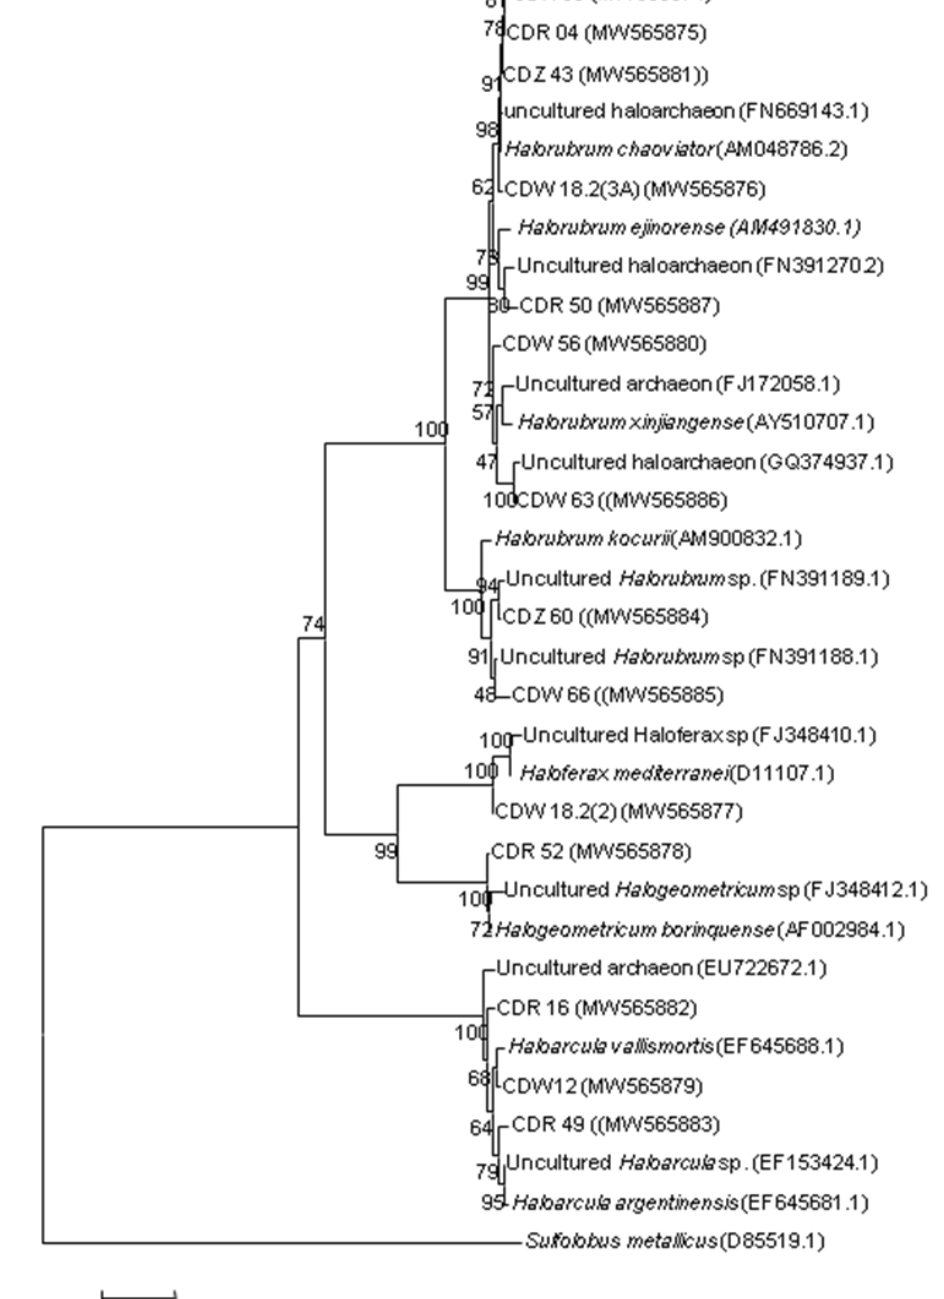
Figure 2. Phylogenetic relationships among haloarchaeal group members, isolated from halite-crystal salts (CDR, CDW, and CDZ), and their closest relatives retrieved from RDPII database. Evolutionary distances were calculated using the method of Maximum Composite Likelihood and the topology was inferred using the neighbor-joining method using MEGA 6. Numbers on the nodes present % bootstrap values based on 1000 replicates. Scale bar represents 0.02 substitutions per site. The 16S rRNA gene sequence of Sulfolobus metallicus was arbitrarily chosen as the outgroup to define the root of the tree. Accession numbers of sequences are shown in parenthesis.